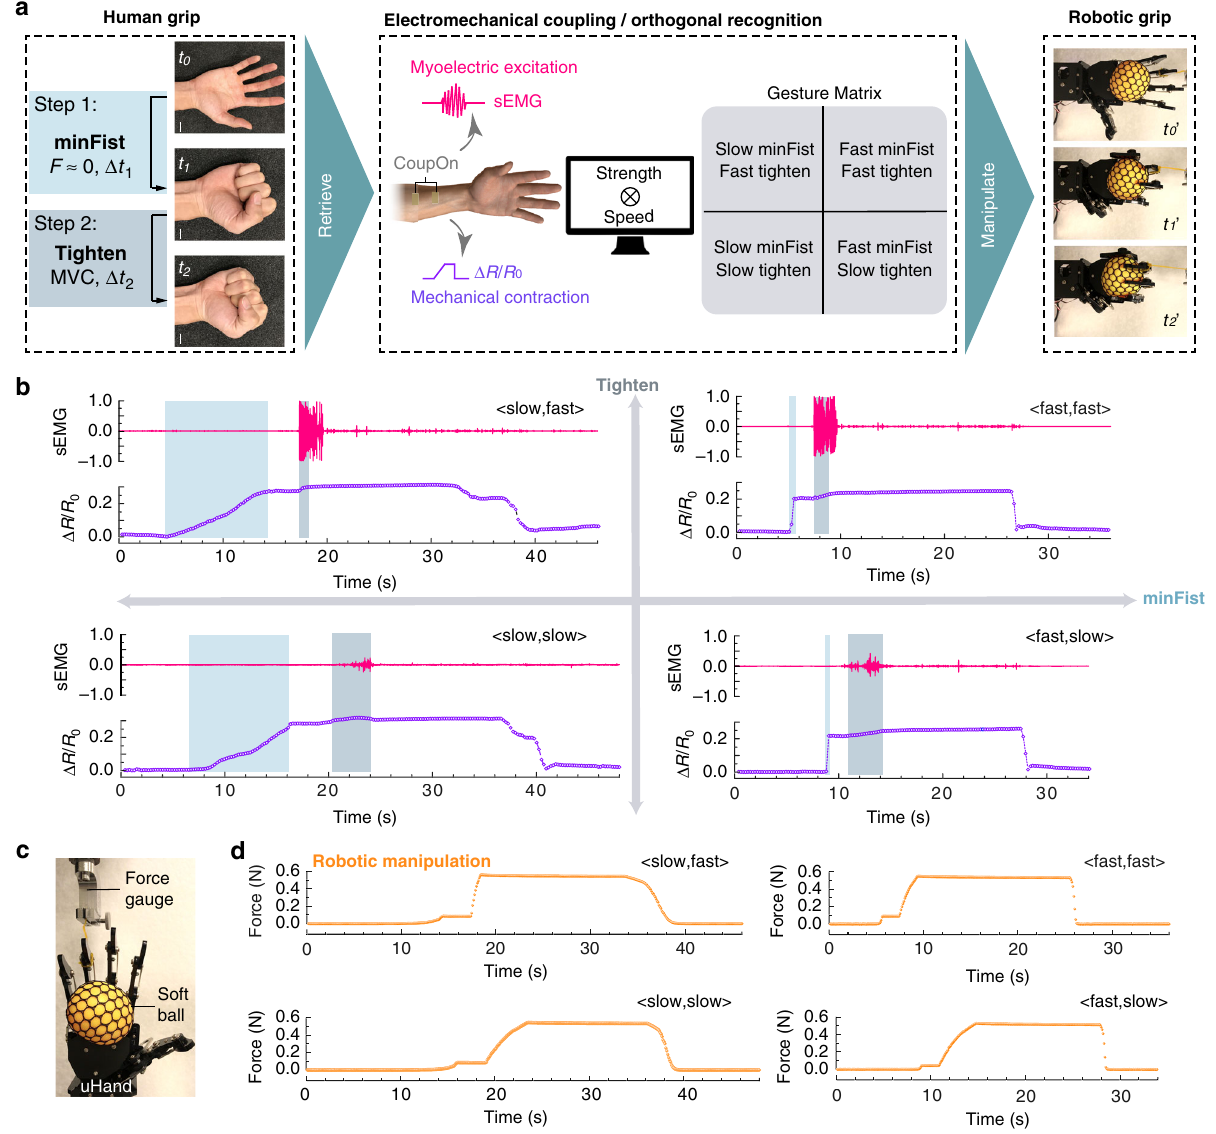
Fig. 6 Orthogonal recognition of human grips for dynamic robotic manipulation. a Schematic shows the process of identifying human grip signatures for manipulating robotic grips. Both human and robotic grips involve two steps, namely the minFist and tightening. The coupled electromechanical patterns retrieved by CoupOn can orthogonally recognize the speed and strength of human grips, therefore allowing the categorization of four permutations in the gesture matrix, according to speed of the two steps. Scale bar, 2 cm. b Plots show the retrieved excitation – contraction signatures corresponding to the four permutations in gesture matrix. Data obtained on subject 5. c Photograph shows the setup for the robotic grip of a soft yellow ball with the ring fi nger connected with a force gauge. d Plots indicate the grip force exerted on the soft ball during the four permutations of recapitulated individuals with a wrist disarticulation amputation 56,63 . In addi- tion, those using ergometer to calibrate global force generation fail to take into consideration of the spatial complexity 20 (e.g., between the muscle belly and myotendinous junction 19 ), which involve complicated techniques (e.g., ultrasonography 19 and